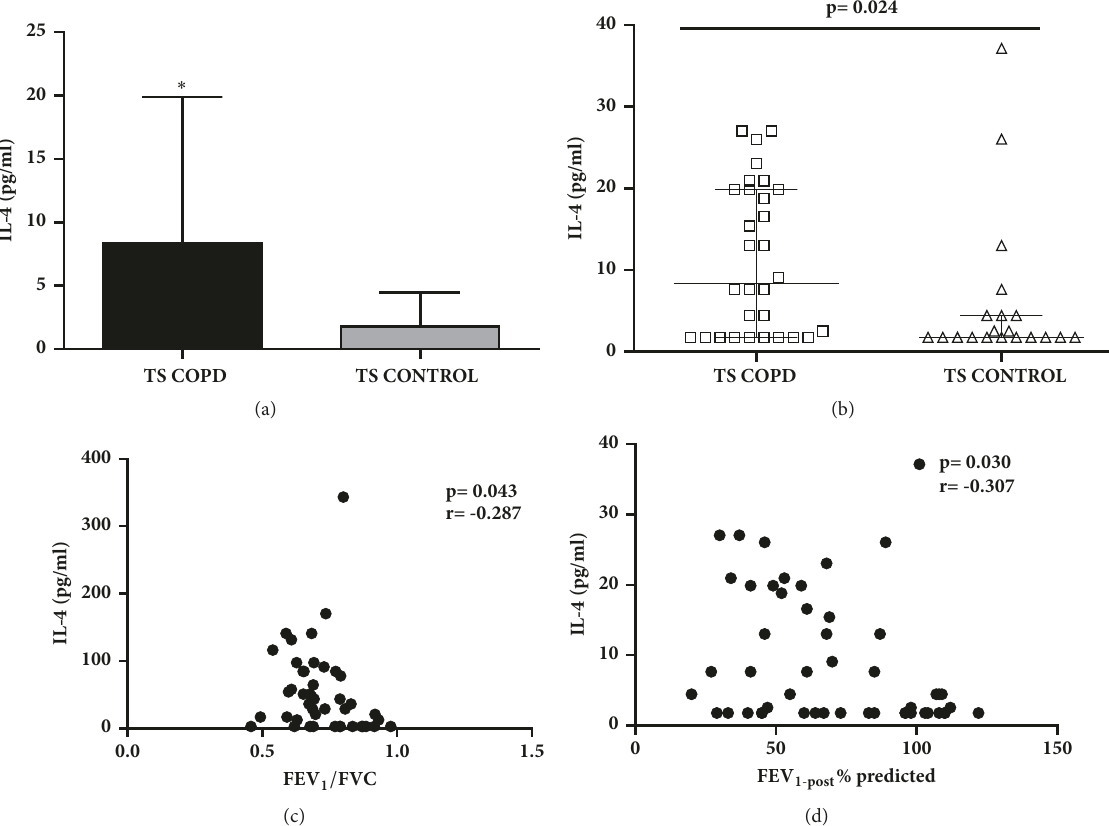
Figure 3: Serum concentrations of interleukin 4 (IL-4) and corresponding correlation with lung function parameters among long-term smokers with or without chronic obstructive pulmonary disease (COPD) . (a, b) IL-4 concentrations were increased in TS COPD group compared to TS CONTROL group (p=0.024); inverse correlation of IL4 concentrations to (c) FEV 1 /FVC and (d) FEV 1( post ) was detected in the study cohort.. Data is presented as median (25th-75th percentile); TS COPD: n=30 and TS CONTROL: n=20; ∗ p < 0.05 was considered as statistically significant. COPD : chronic obstructive pulmonary disease; FEV 1 : forced expiratory volume 1 second prebronchodilator (pre) challenge; FEV 1 :FEV 1 postbronchodilatorchallenge; TSCOPD :tobaccosmokerswithCOPD; TSCONTROL :tobaccosmokerswithout (post)